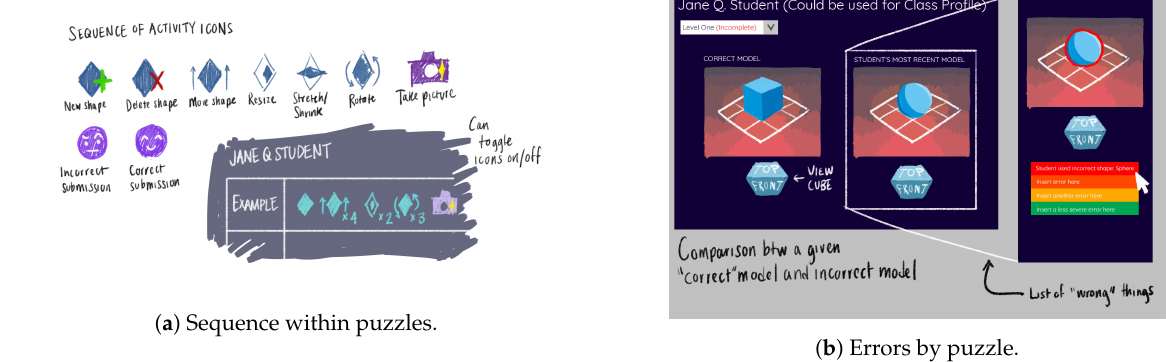
Figure 3. Two examples of digital paper prototype